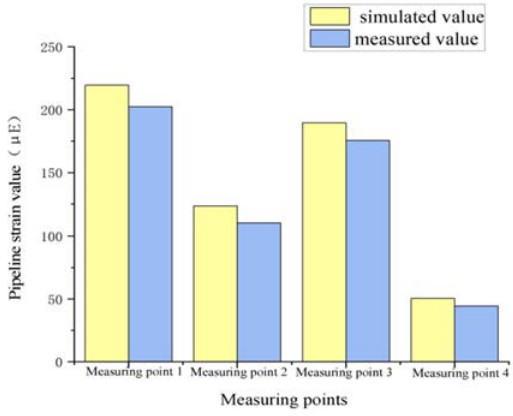
Figure 10. Comparison of pipe strain values.